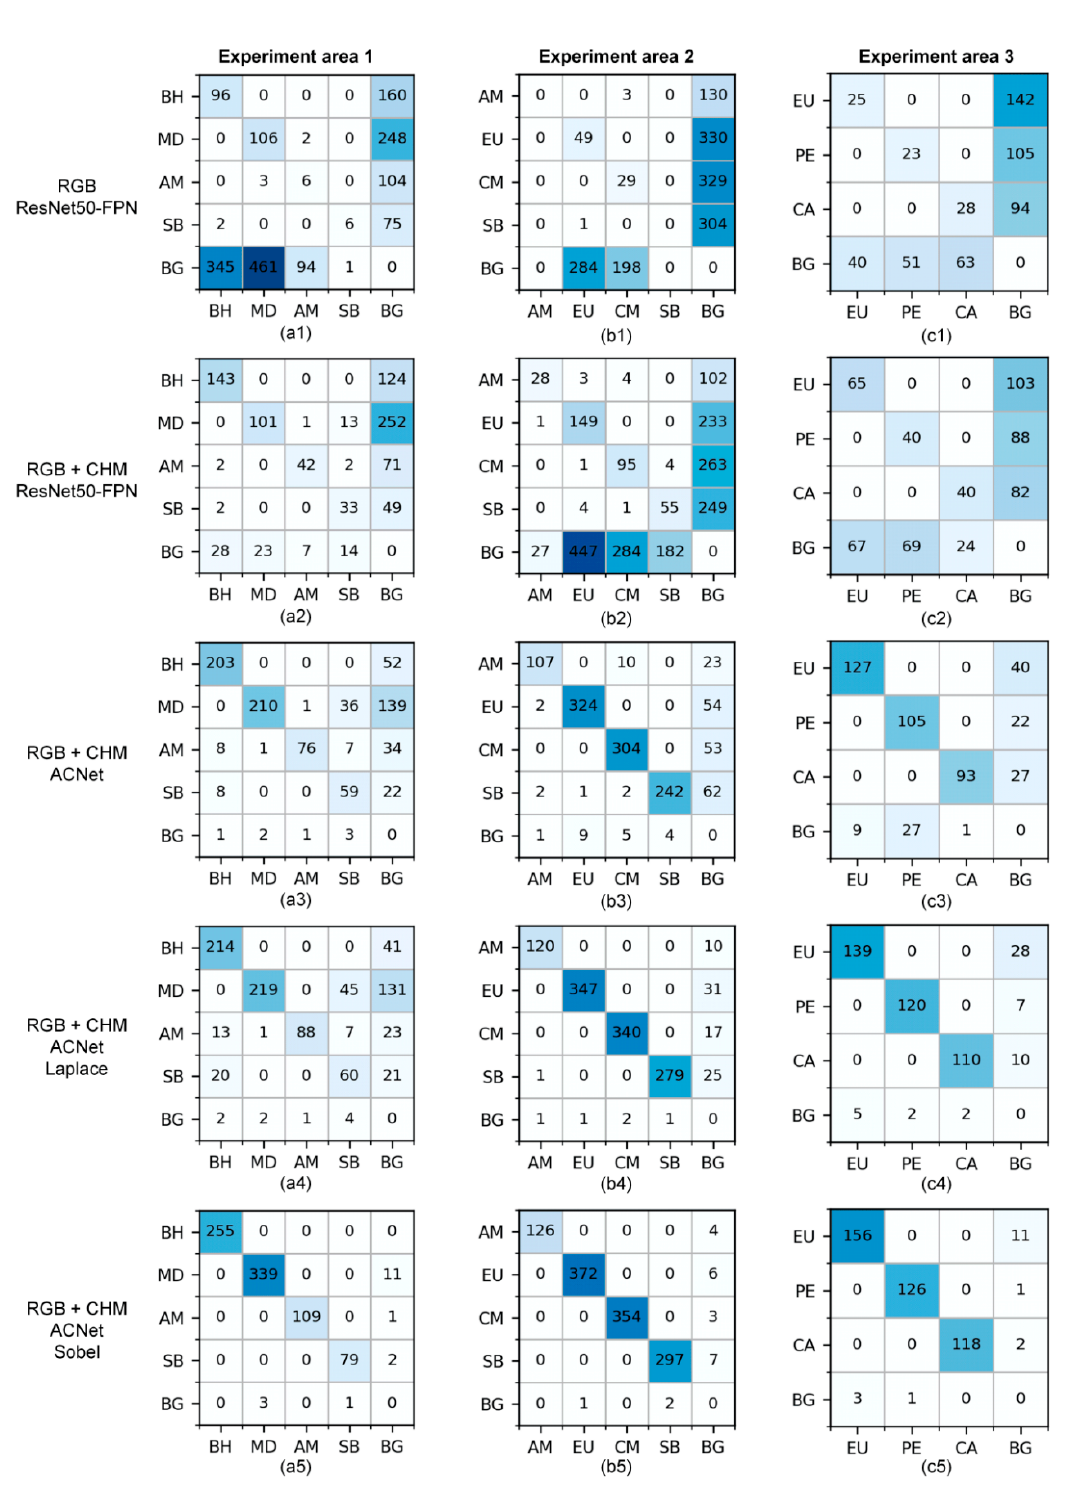
Figure 8. The confusion matrix of individual tree species identification for three experimental areas by different experiment schemes. Different experiment schemes are shown on the left of the figure. ( a – c ) Experimental areas 1, 2, and 3, respectively. BG stands for background.